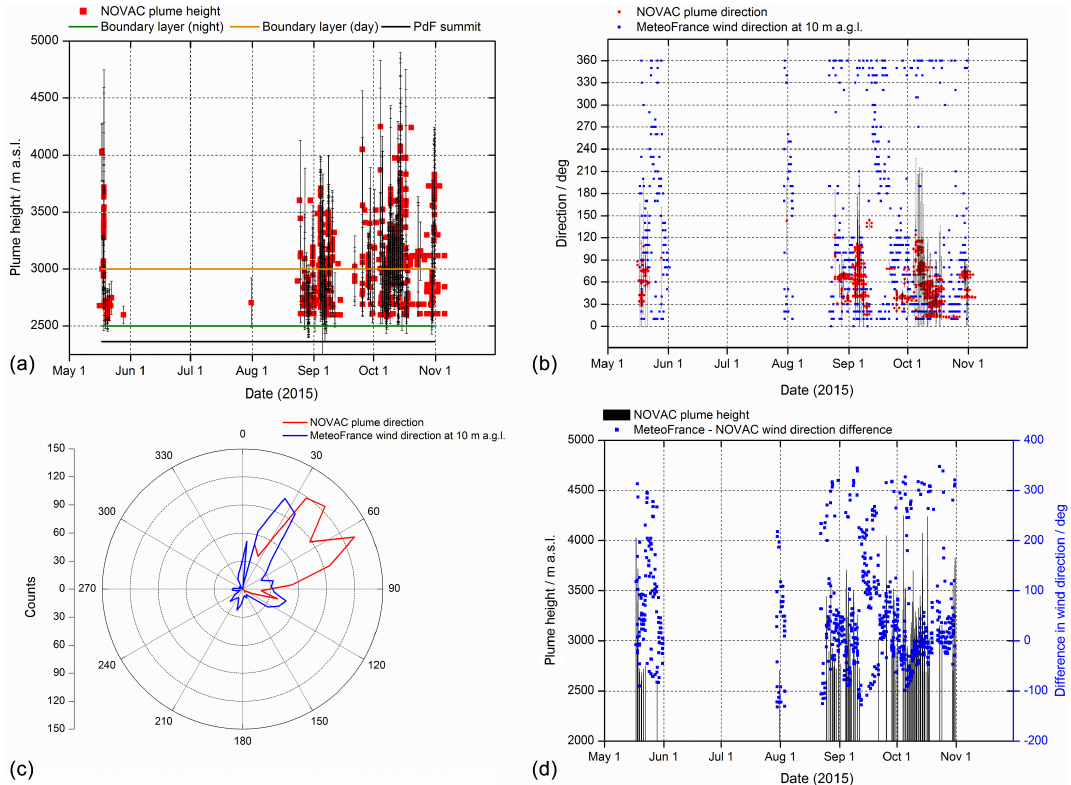
Figure 5. Time evolution of the plume height (a) and plume direction (b) computed by triangulation of nearly simultaneous scans of two permanent DOAS stations of OVPF (NOVAC network) and by the Météo-France station. (c) Wind rose of the wind direction as indicated by the plume trajectory measured by the scanners, and wind direction measured by the meteorological station. (d) Difference between the plume direction derived by DOAS and the wind direction at the Bellecombe Météo-France station, and plume height.